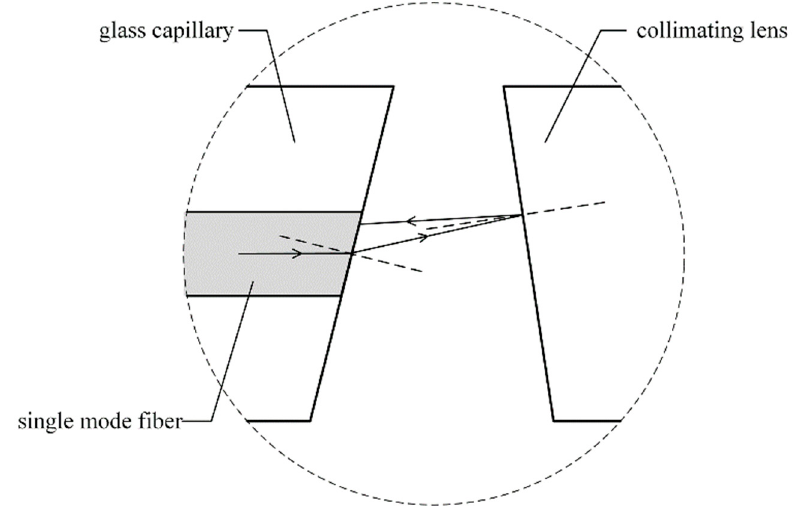
Figure 4. Back flection from the left facet of the collimating lens.